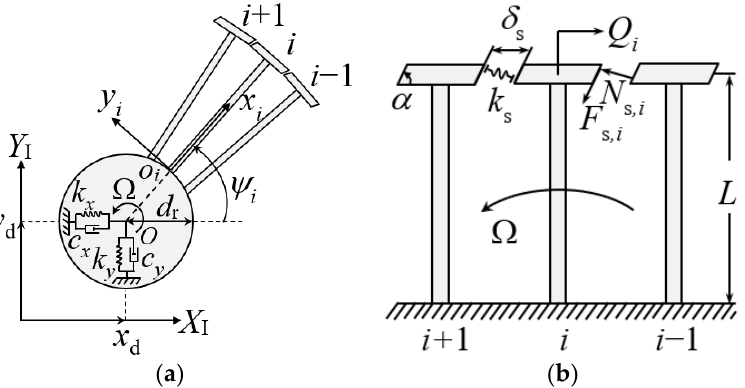
Figure 2. Schematic of the mechanical model of a shrouded blisk. ( a ) Disk model and ( b ) Blade geometry in the plane of rotation.